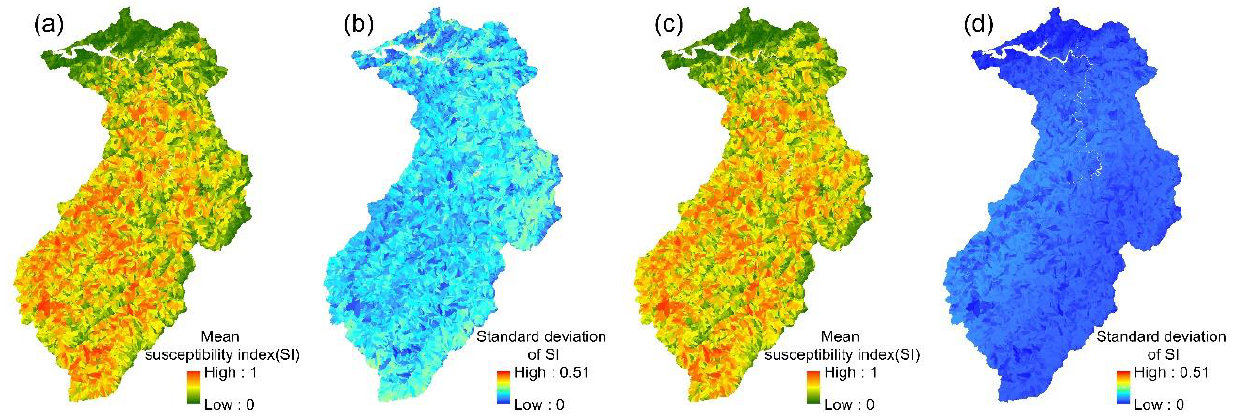
Figure 4. LR models: ( a , b ) the mean susceptibility index and standard deviation of 24 event-based models; ( c , d ) the mean susceptibility index and standard deviation of the multi-year model.